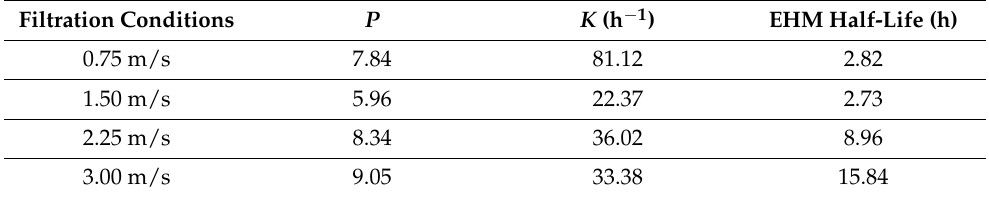
Table 12. EHM parameters for the regressions obtained in Example 4 for different cross-flow velocities.